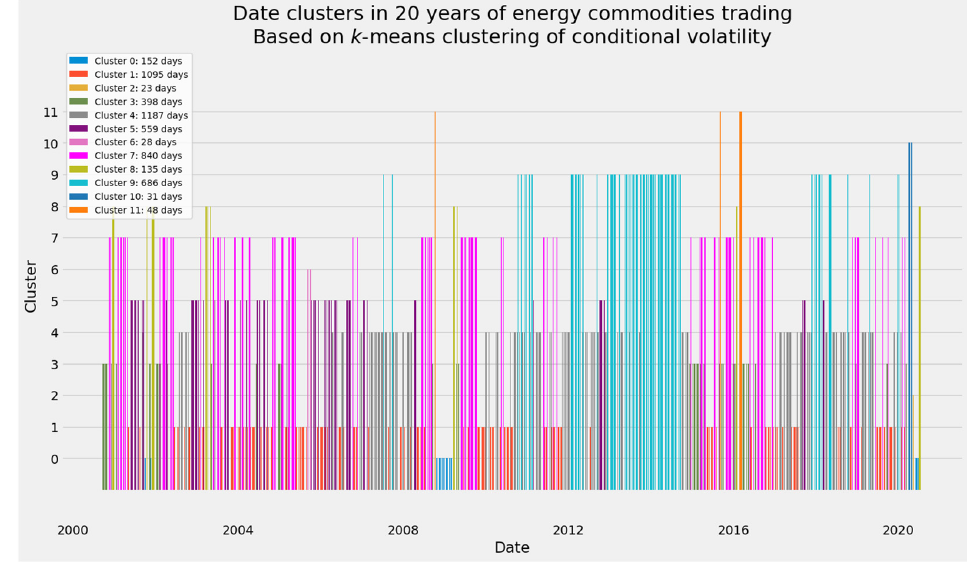
Figure 34. k -means clustering of energy-related markets—An ordered timeline.